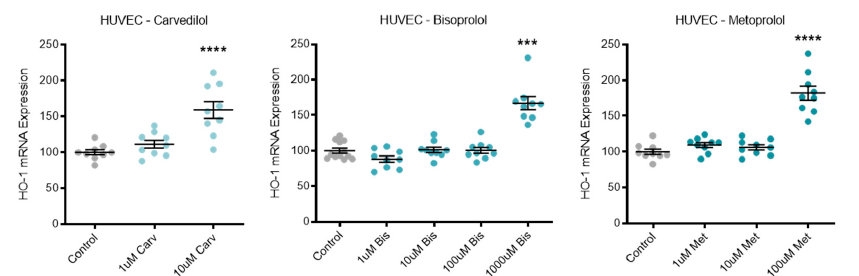
Figure 5. Antioxidant HO-1 is increased with beta-blocker treatment. Expression of HO-1 mRNA is significantly increased in HUVECs following top dose beta-blocker treatment with carvedilol (Carv), bisoprolol (Bis), and metoprolol (Met). Data are mean ± SEM, expressed as a percentage of control, n = 3–4, *** p < 0.001, **** p < 0.0001.